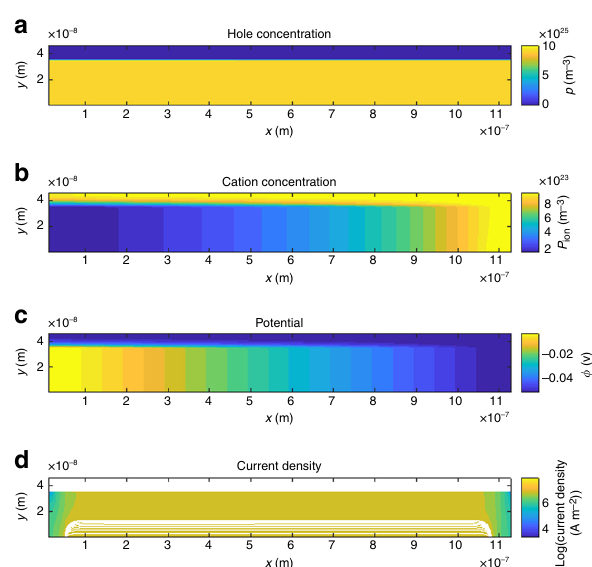
Fig. 6 Simulation results for short-channel OECTs. a Hole concentration p ( x , y ), b cation concentration p x , y ), c electric potential Φ ( x , y ), and ion ( d hole current density j p ( x , y ) calculated using the parameters summarized in Supplementary Table 1 at V DS = − 2 V T and V GS,int = − 2 V T . Streamlines are shown in the bottom panel indicating the current fl ow from the source electrode on the left to the drain electrode on the